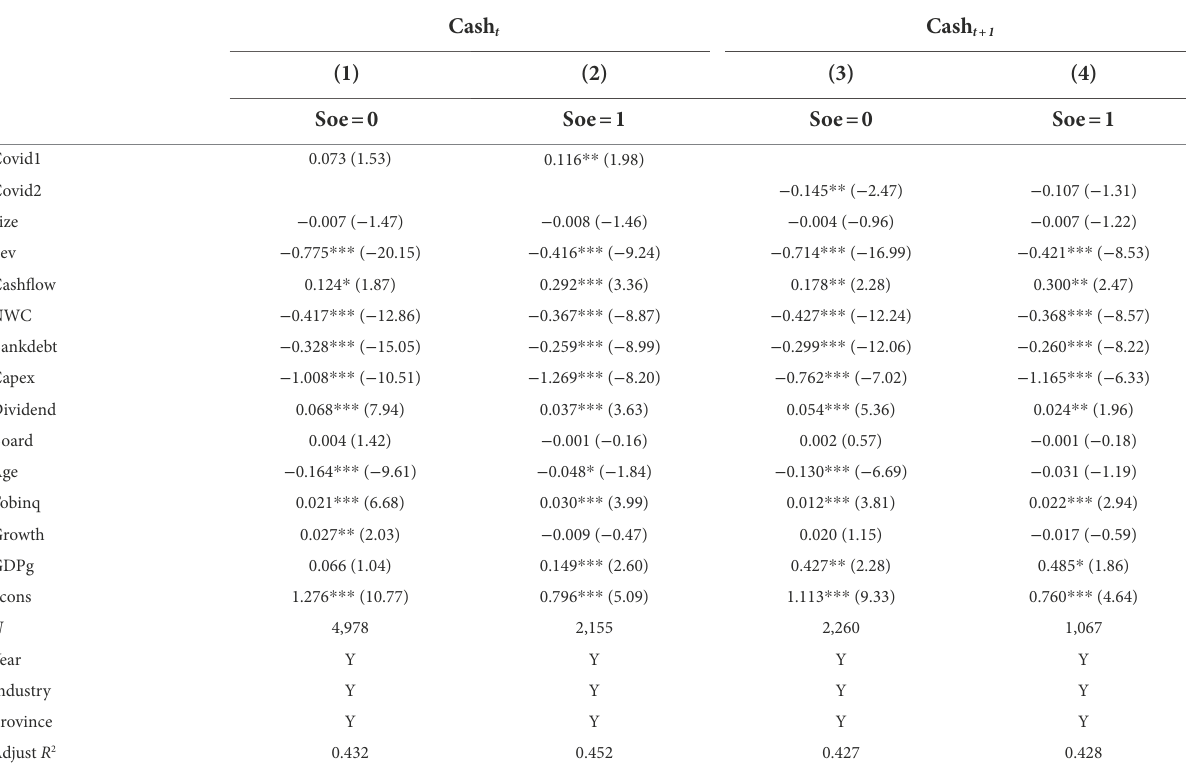
TABLE 12 COVID-19 impact and corporate cash holdings: based on the type of